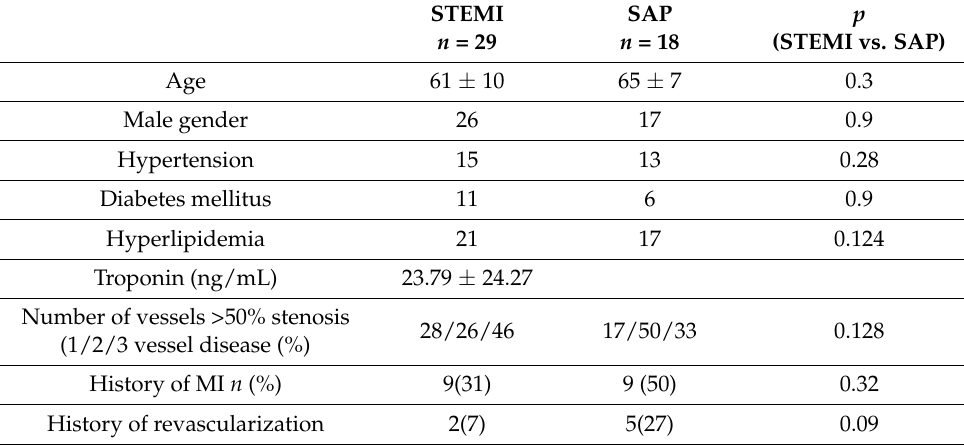
Table 1. Patient characteristics.